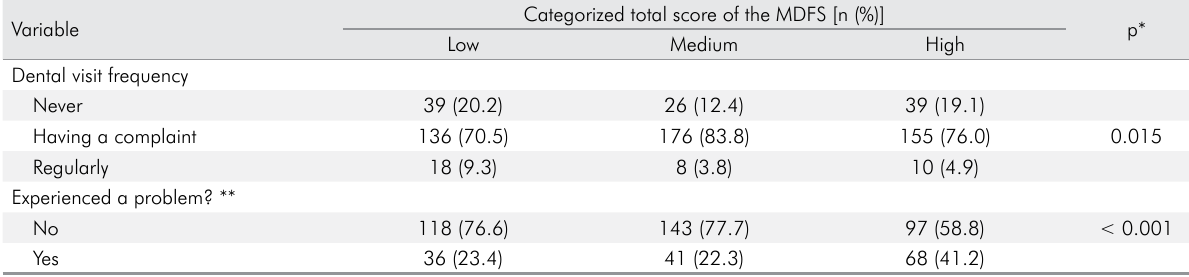
Table 2. Relationship between dental history and categorized total score of the MDFS (n = 607).